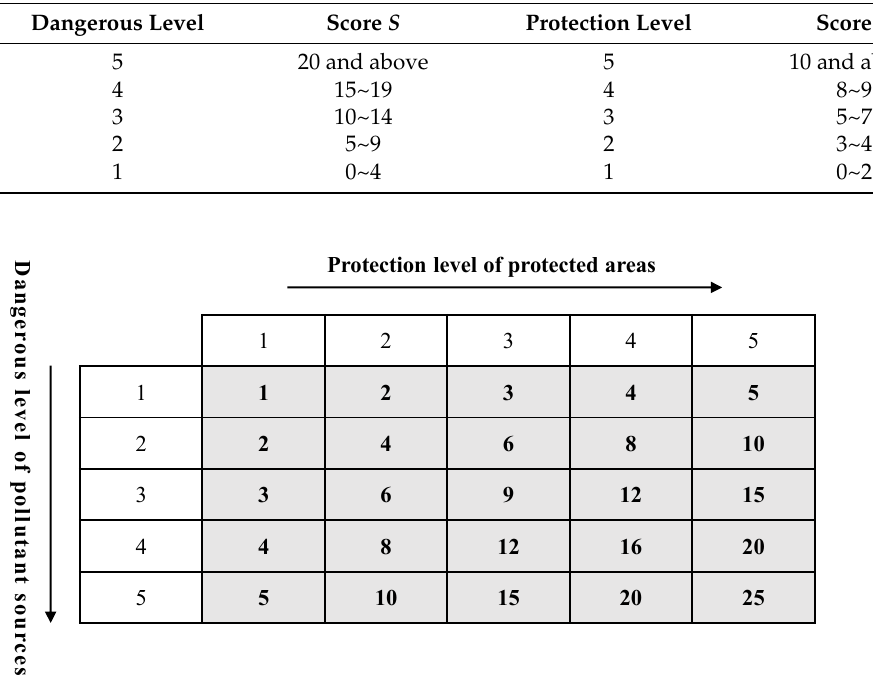
Figure 6. Matrix method used to determine the severity level of environmental consequences.